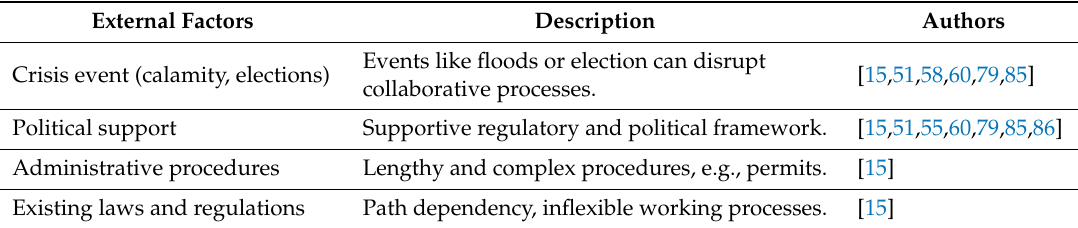
Table 4. External context factors influencing the social learning